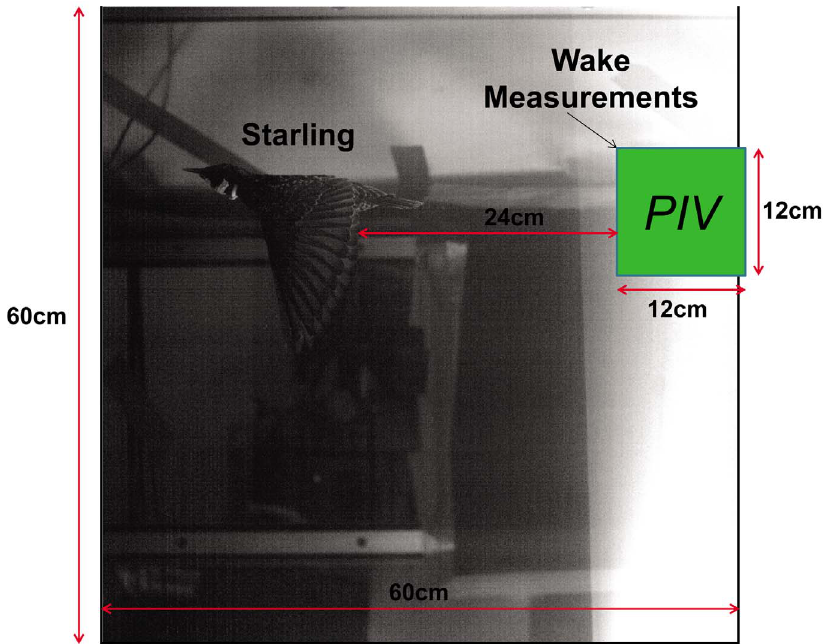
Figure 2. The large image shows the kinematic camera field of view and the small window marked ‘‘PIV’’ is the PIV camera field of view.